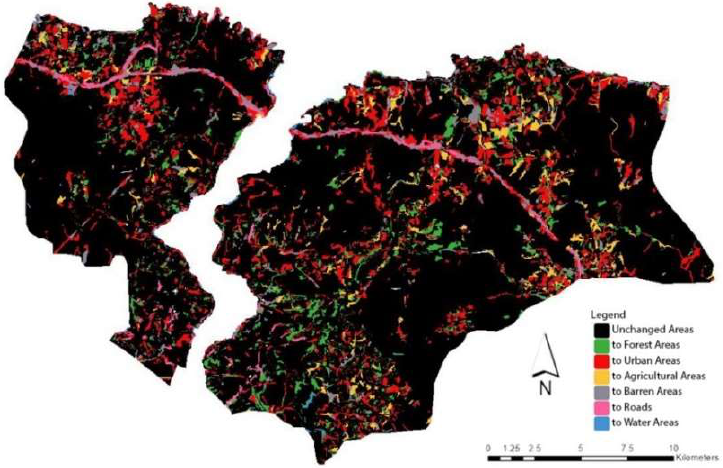
Figure 4. LULC change analysis.